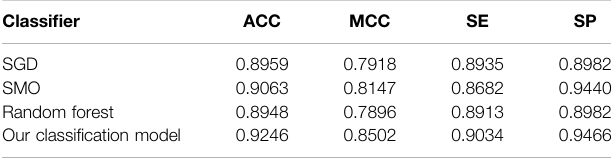
TABLE 4 | Result of different classi fi ers on Test-2698.